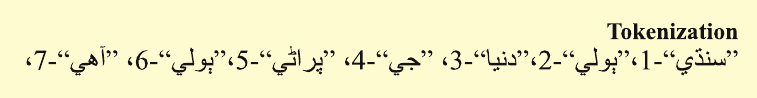
FIG. 1. TOKENIZATION OF SINDHI TEXT DOCUMENT